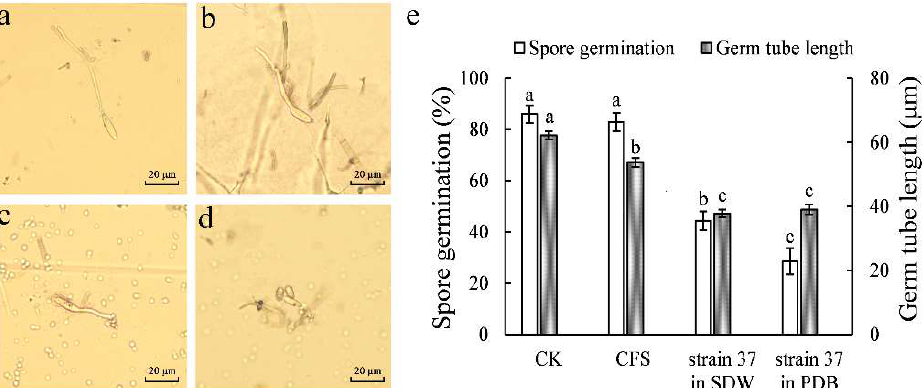
Figure 4. Efficacy of different treatments of M. guilliermondii 37 on the spore germination of B. dothidea . The spores were cultured in PDB medium CK ( a ); CFS ( b ); M. guilliermondii 37 suspensions in SDW ( c ); and M. guilliermondii 37 suspensions in PDB ( d ) for 2 h, respectively. Scale bar = 20 µ m. Germination rate and germ tube length were assessed ( e ). The data are shown as mean ± SE. The letters above the columns show statistically significant differences ( p < 0.05) as assessed with Duncan’s multiple range test.